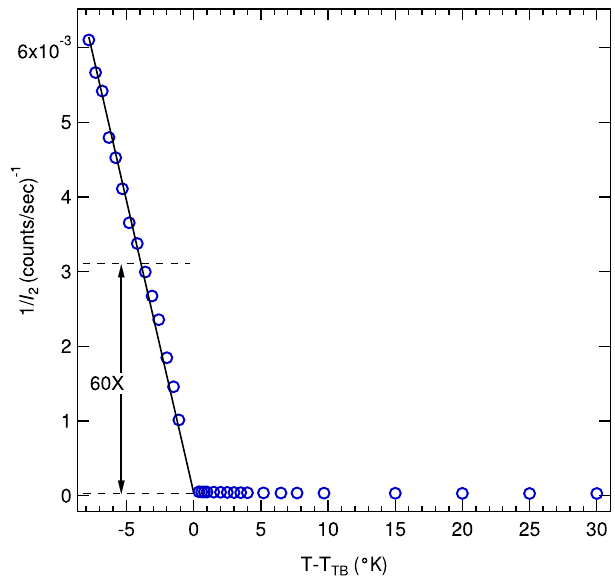
FIG. 7. Temperature dependence of the inverse of the total scattering intensity I − 1 2 recorded in geometry G2 for θ i ¼ 15 °, θ ¼ 40 °. The solid line is a linear fit of the data for T < T s